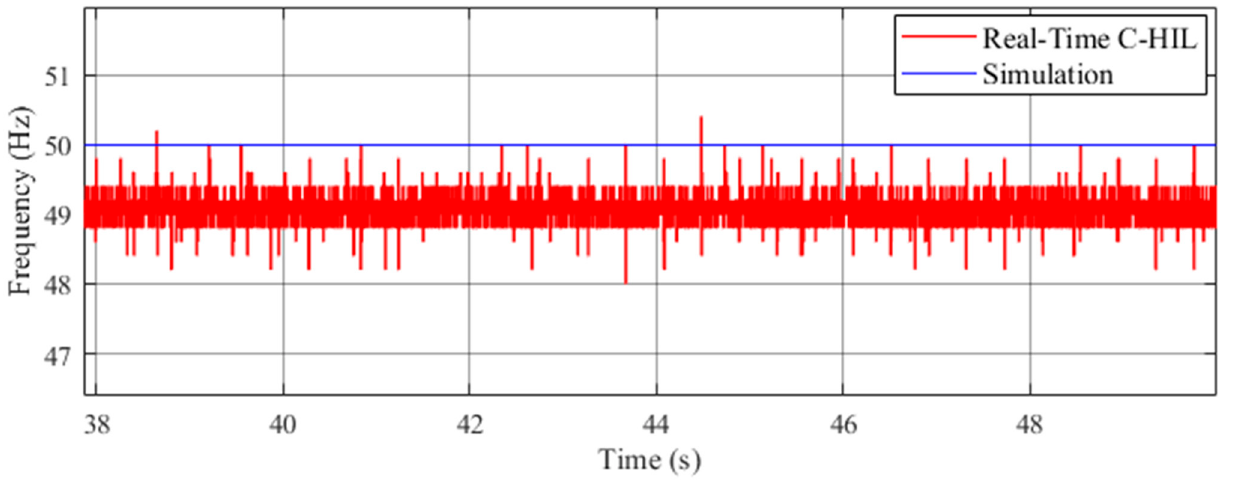
Figure 26. System frequency.